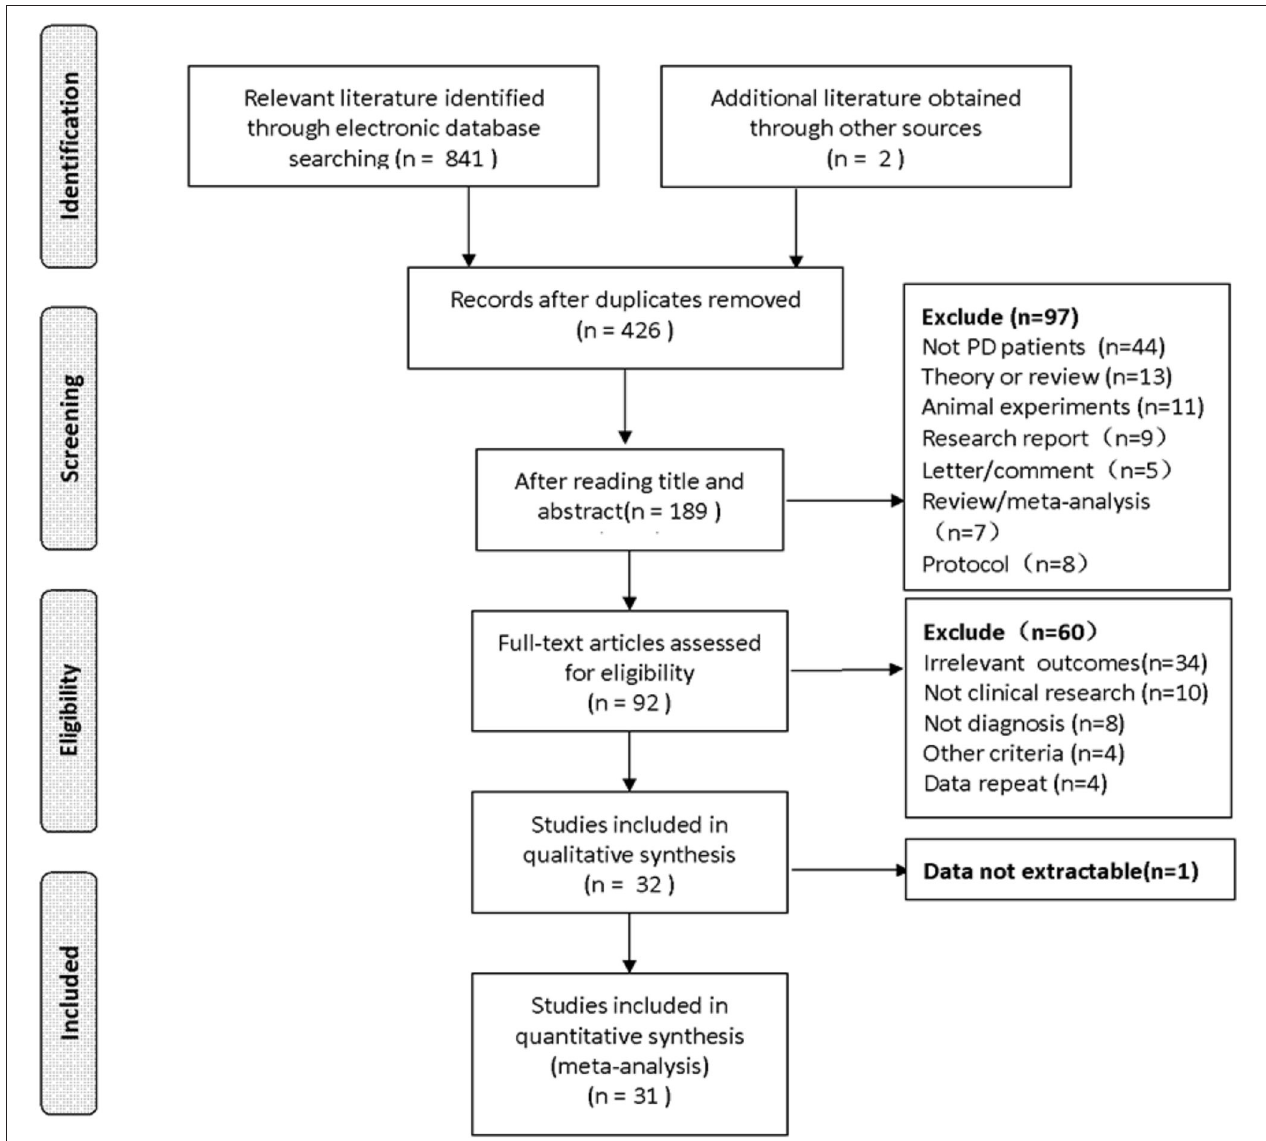
FIGURE 1 | Flow diagram of literature selecting process and results according to the preferred reporting items for the meta-analysis. PD, Parkinson’s